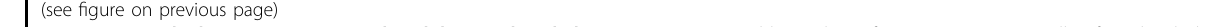
Fig. 6 TM9SF1 depletion reverses PCIF1 knockdown-induced phenotypes. a Western blot analysis of TM9SF1 in BGC-823 cells infected with the indicated lentivirus-based shRNAs. b , c Migration analysis of BGC-823 cells with the indicated lentivirus-based shRNAs. Representative images of invaded cells are shown ( b ). The invaded cells were quanti fi ed ( c ). Scale bars, 100 μ m. d – f BGC-823 cells with the indicated lentivirus-based shRNAs were intravenously injected into SCID mice, respectively. Representative images of gross lungs and H&E-stained lung are shown ( d ). The lung weight ( e ) and the number of metastatic nodules (>1 mm) ( f ) were quanti fi ed. Scale bars, 1 cm. g The working model of PCIF1-dependent m 6 Am modi fi cation of TM9SF1 mRNA to promote gastric cancer progression. When PCIF1 level is high, it modi fi es TM9SF1 mRNA with m 6 Am leading to decreased translational ef fi ciency of TM9SF1 . The downregulated protein level of TM9SF1 enhance gastric cancer cell malignancy. And depletion of PCIF1 promotes the translation of its target mRNA TM9SF1 . Ectopic TM9SF1 inhibits tumor growth and metastasis of gastric cancer cells. Data are shown as means ± SD. ** P < 0.01, ** *P < 0.001, Student ’ s t- test ( c ), Mann – Whitney test ( e , f